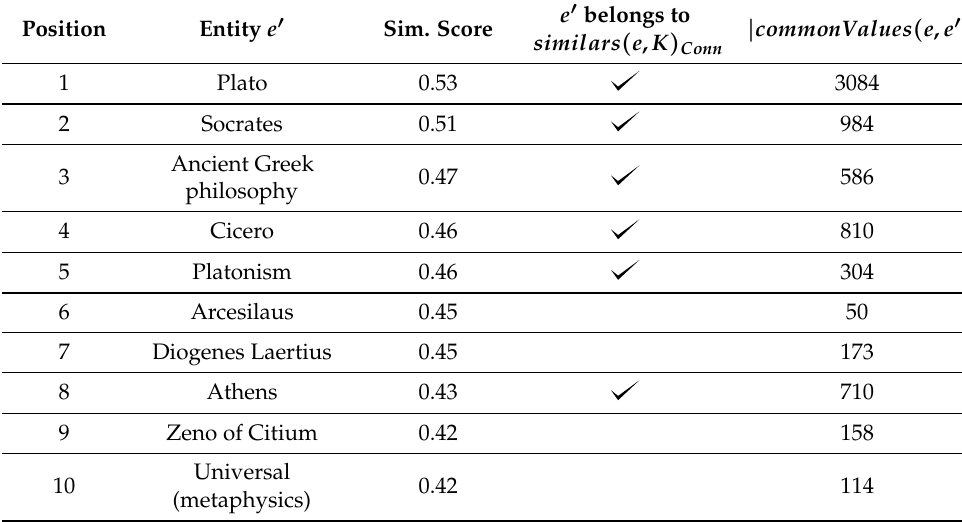
Table 5. Similarity Measurements for the top-10 similar entities to Aristotle.